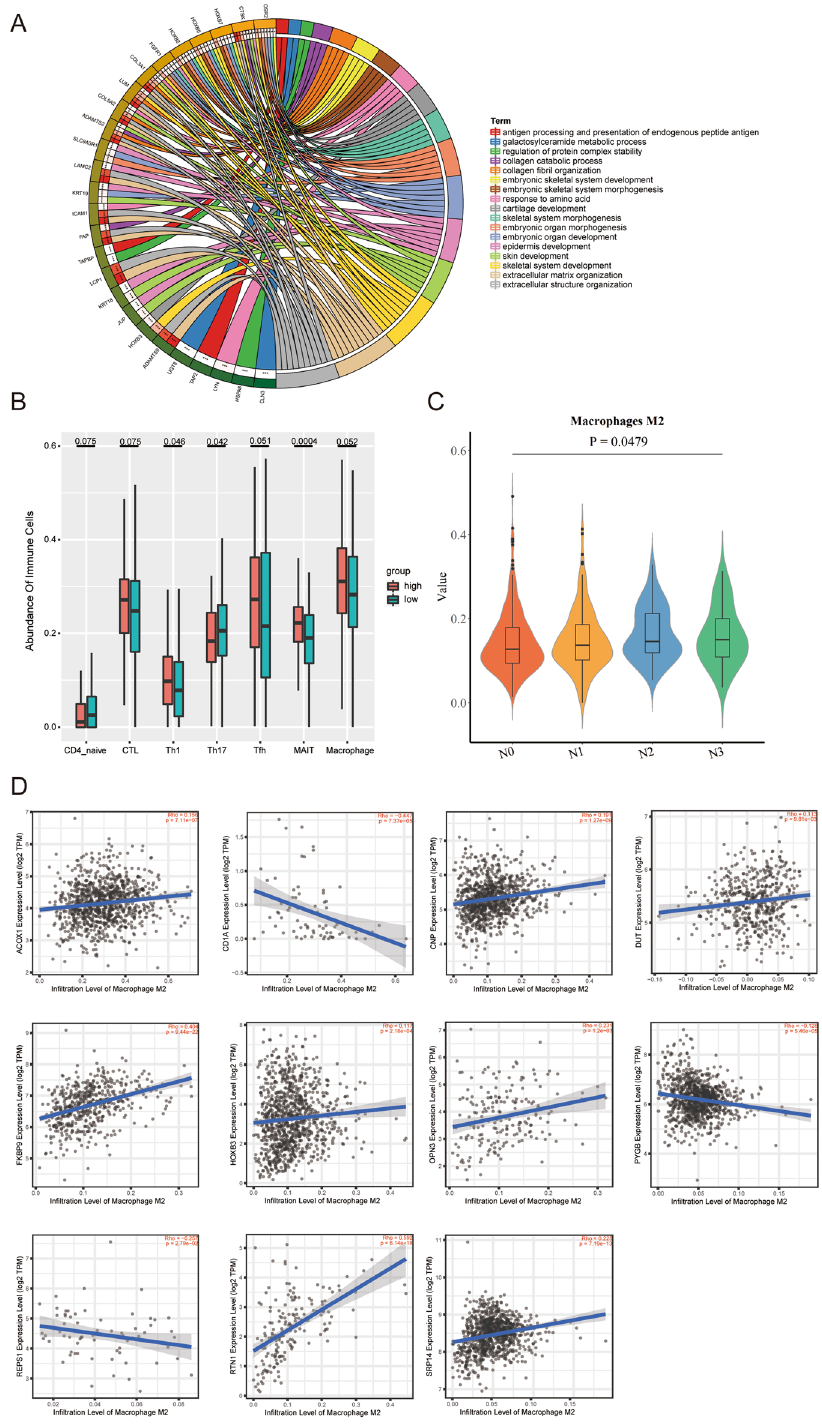
Figure 6. Analyses of gene function and tumor immune infiltration. ( A ) GO results revealed that the DEGs were involved in some immune-related processes; ( B ) Risk cores correlated with immunocyte infiltration in the TCGA cohort; ( C ) Lymph node stage in breast cancer correlated with M2 macrophages; ( D ) Correlation of the expression of 11 genes with M2 macrophages in breast